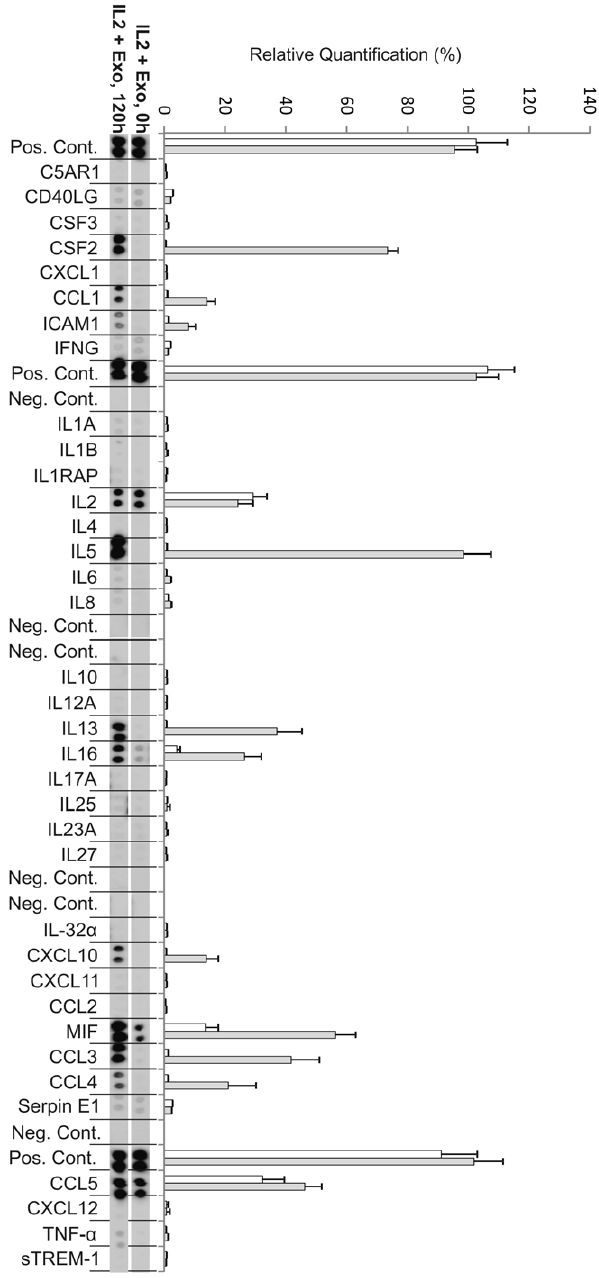
Figure 6. Cytokine production from exosome + IL-2 stimulated CD3 + T cells at day zero (0 h) and day five (120 h). Relative quantification of spot intensities was performed using Quantity One software (Bio-Rad). Each bar represents an average of the intensity from two protein spots. White bars represent 0 h and grey bars represent 120 h (day 5). The cytokines IL-5, IL-13 and GM-CSF as well as the chemokines CCL3 and CCL4 were present at higher levels at day five.